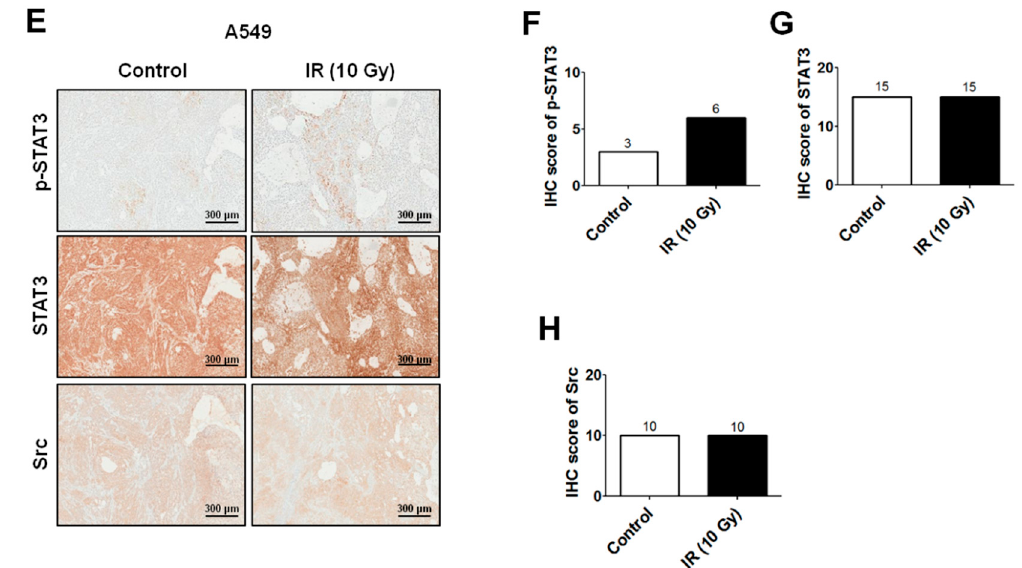
Figure 3. IR induces RIP1 expression and activates epithelial-mesenchymal transition (EMT) in vitro/in vivo. ( A ) Lysates from A549 cells treated with IR (10 Gy) were subjected to immunoblotting to examine the expression levels of RIP1, MMP-2, MMP-9, EGFR, p-EGFR, Src, p-Src, STAT3 p-STAT3, vimentin and β -actin (loading control). Representative data from triplicate experiments are shown. ( B ) A549 cells were exposed to IR (10 Gy) and treated with gefitinib (EGFR inhibitor, 10 μ M). Immunoblotting was applied to examine the expression of RIP1, MMP-2, MMP-9, EGFR, p-EGFR, Src, p-Src, STAT3, p-STAT3, vimentin and β -actin (loading control). Representative data from triplicate experiments are shown. ( C , D ) A549 cells subjected to IR (10 Gy) were treated with Src (20 μ M) or STAT3 inhibitor (20 μ M) for the indicated periods and Western blot analyses for RIP1, vimentin, MMP-2, MMP-9, Src, p-Src, STAT3, p-STAT3 and β -actin (loading control) were conducted. Data are representative of triplicate experiments. (***; p < 0.001) ( E ) A549-tumor xenografts in response to sham irradiation or irradiation with 10 Gy. Tumors were harvested 48 h after irradiation. Immunohistochemical (IHC) analysis of xenograft tissues of mice after irradiation was performed with antibodies against p-STAT3, STAT3 and Src. Hematoxylin and eosin (H&E) staining of xenograft tissues in mice after irradiation with 10Gy. Scale bar indicates 300 μ m. ( F – H ) The correlation plot of IHC-score quantification for p-STAT3, STAT3 and Src. The IHC scores for p-STAT3, STAT3 are shown in ( F , G ), respectively. The IHC score for Src is shown in ( H ).